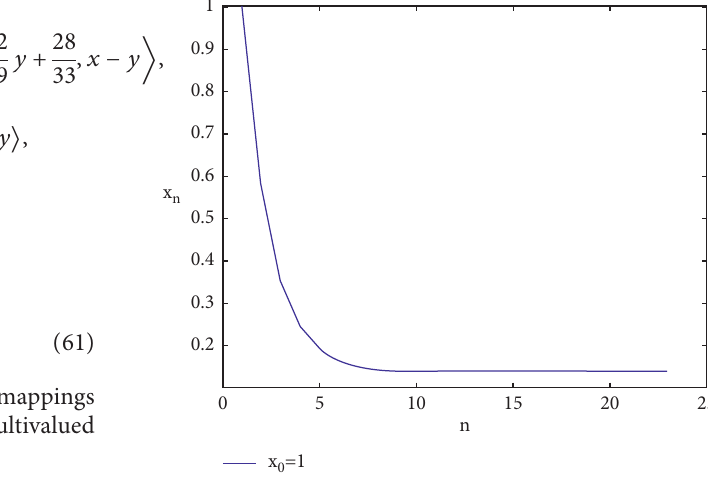
Figure 1: Case 1: for the initial value x